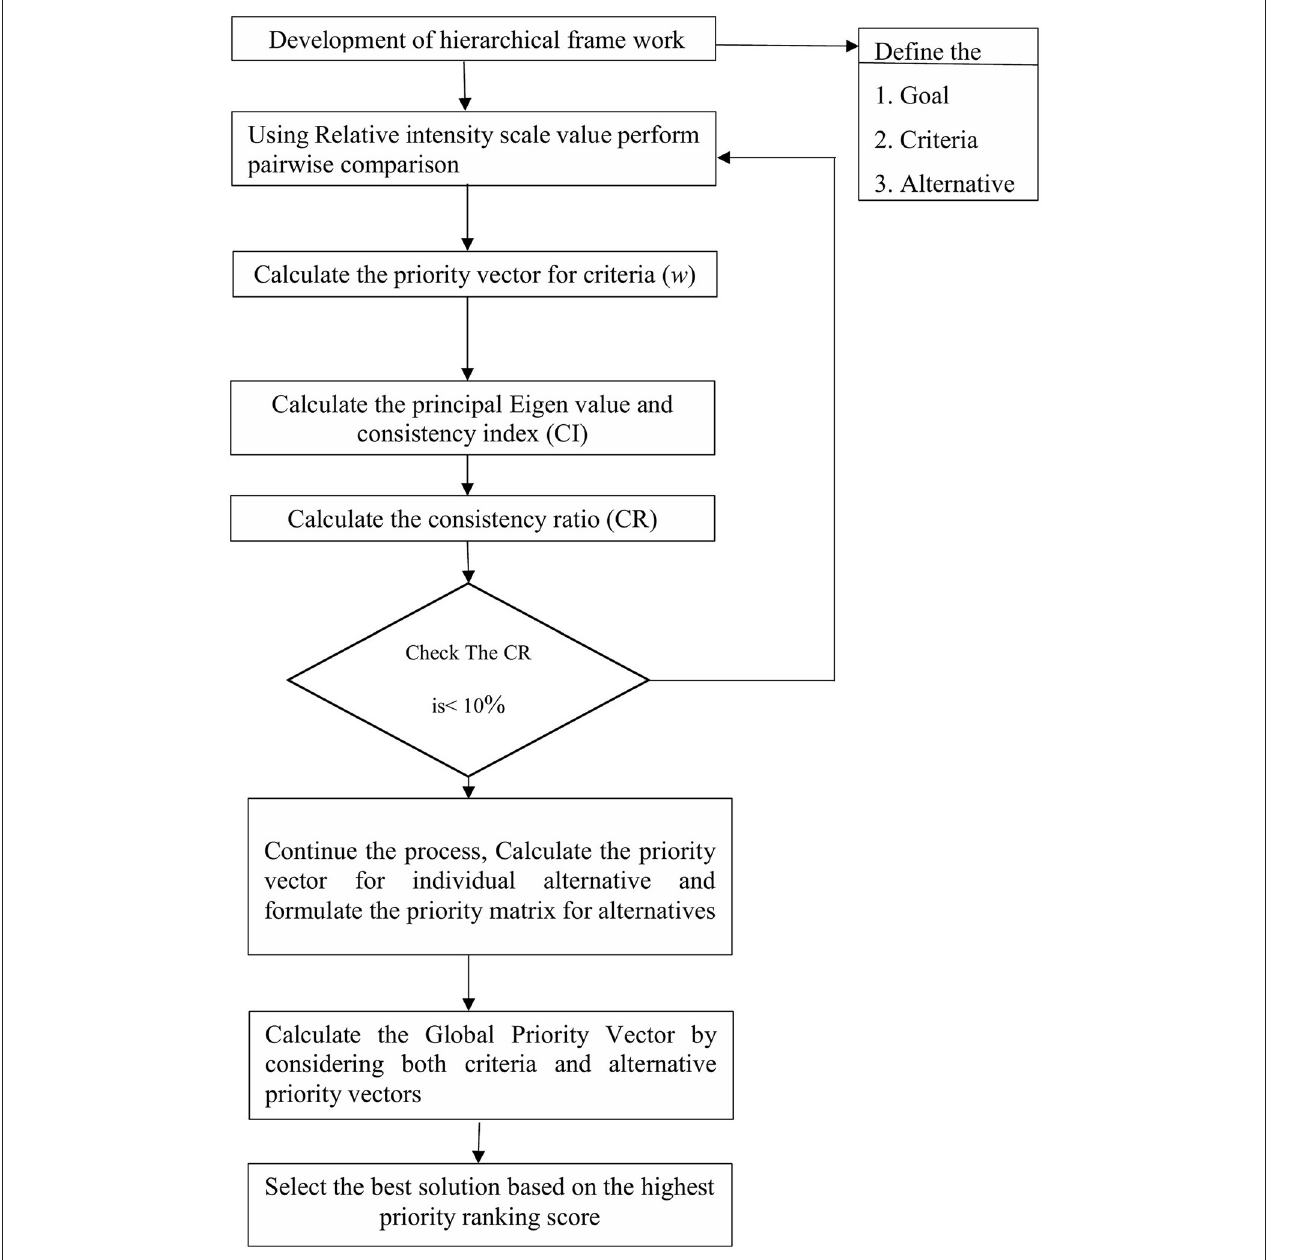
FIGURE 2 | General AHP